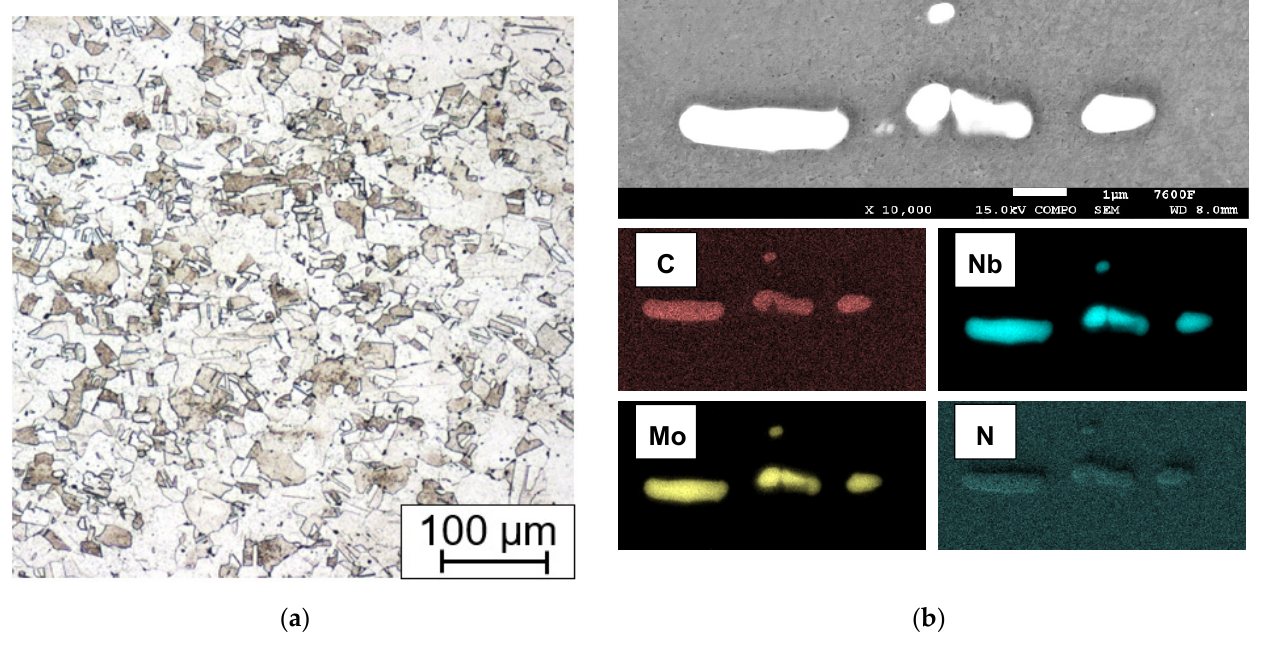
Figure 10. As-received state, ( a ) electrolytic etching (15 V DC, 40 s) in 10% aqueous acetic acid (LOM micrograph); ( b ) strengthening particles type Nb(C,N) EDXS element mapping in the longitudinal section.